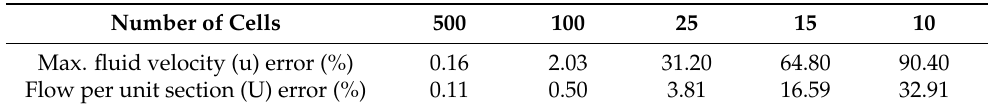
Table 3. Parameters that are different from the reference case. Two-parallel-plate channel composed of two porous materials.